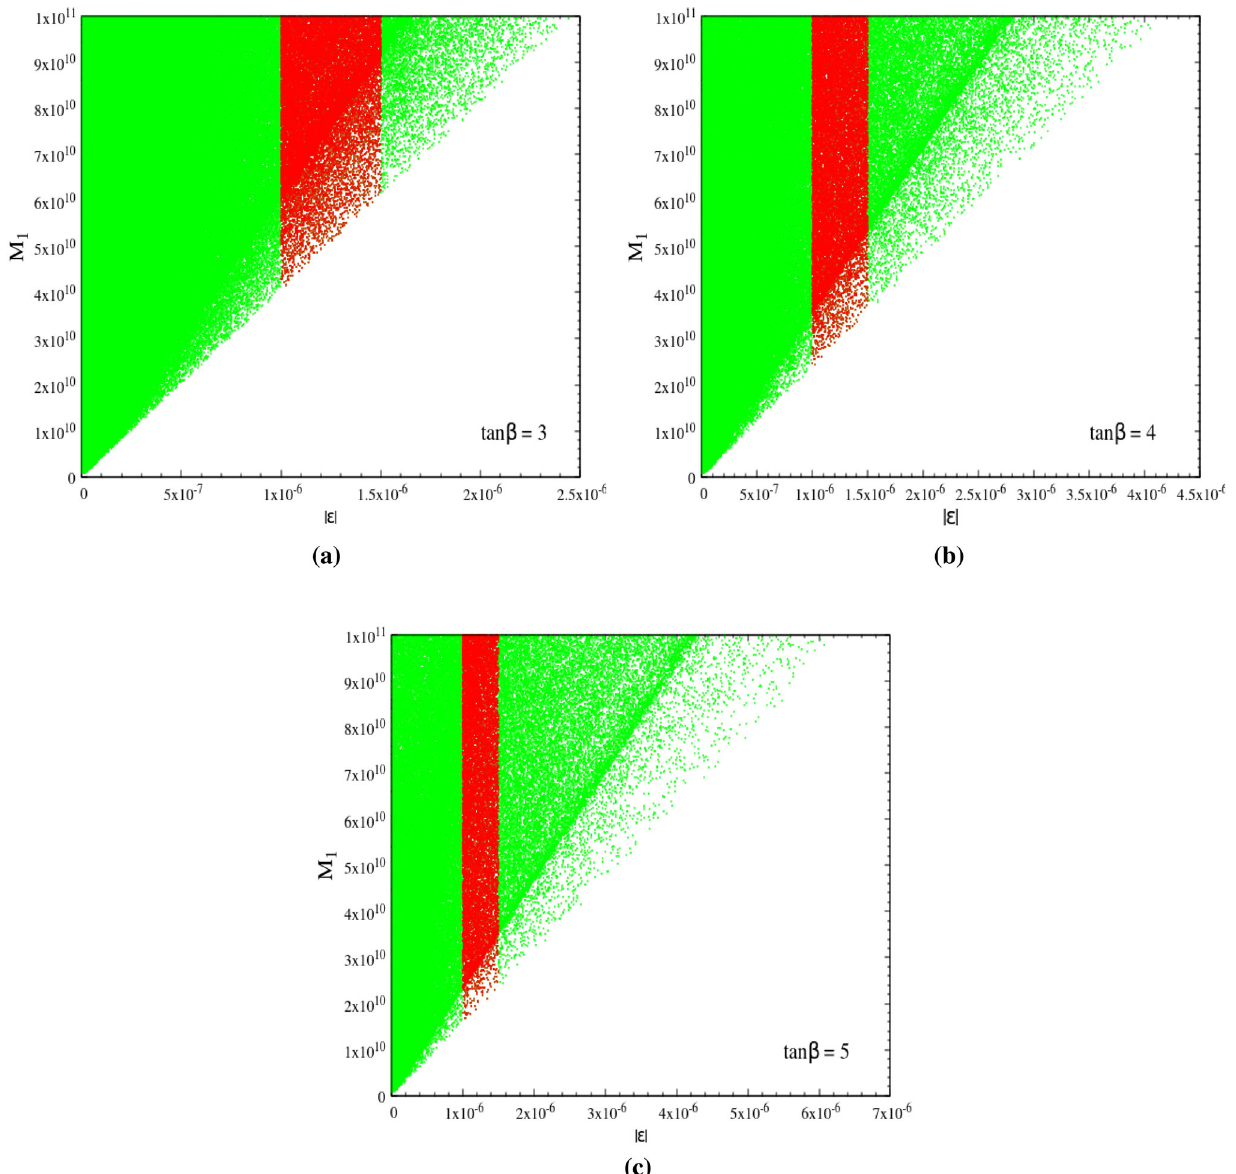
Fig. 6 Region allowed by neutrino oscillation data in M 1 vs . | (cid:3) | plane. Green region corresponds to the points with no constraint on | (cid:3) | , whereas red points satisfy : 1 × 10 − 6 < | (cid:3) | < 1 . 5 × 10 − 6 . Figures are drawn for tan β = 3 (upper panel left), tan β = 4 (upper panel right), tan β = 5 (lower panel)